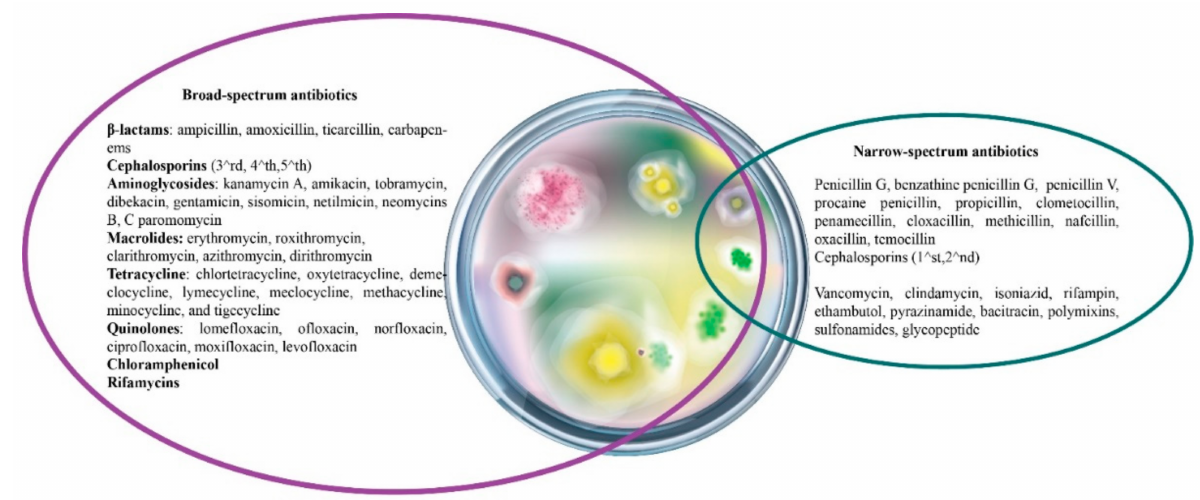
Figure 8. Graphical representation of broad- and narrow-spectrum